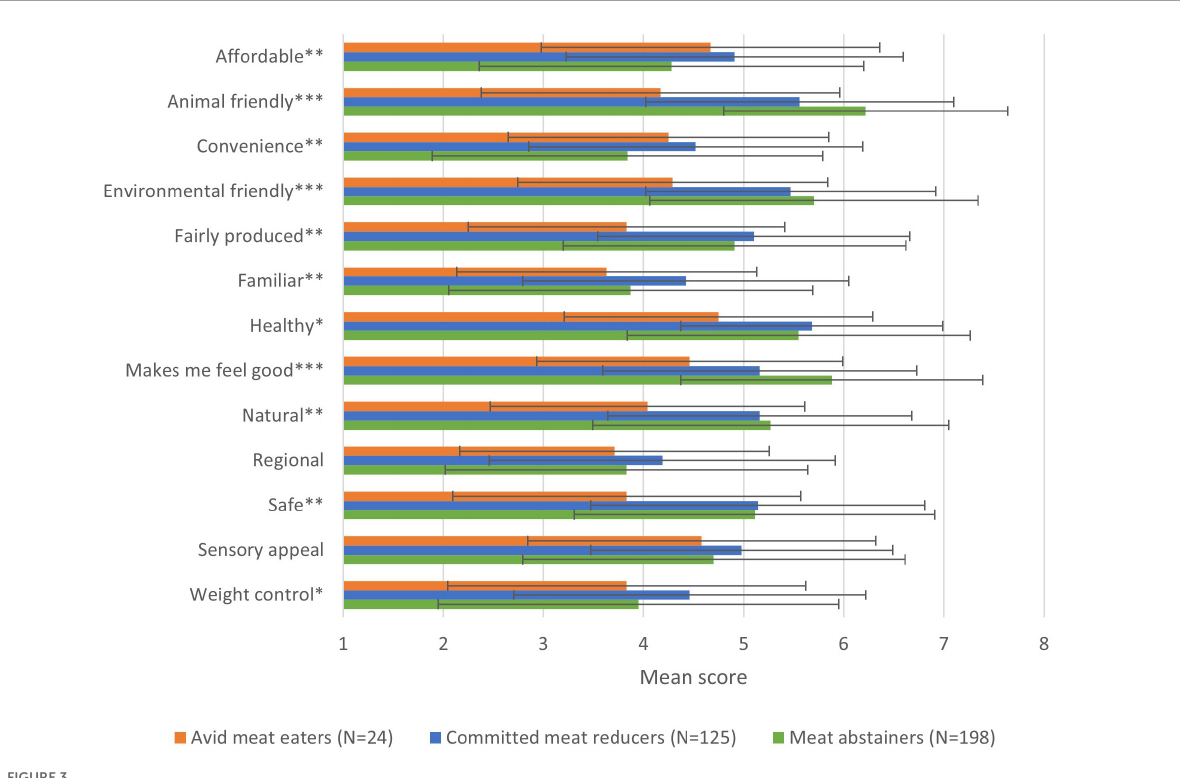
FIGURE3 Mean scores of motives to limit meat consumption per dietary consumer group (* p < 0.05, ** p < 0.01, *** p < 0.001).